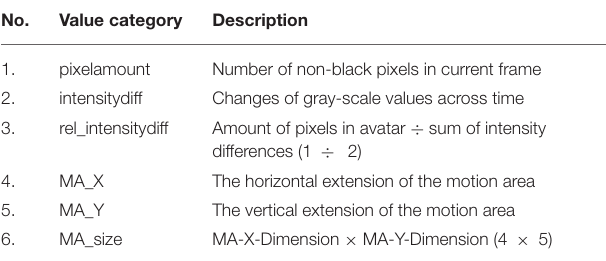
TABLE 3 | Overview of Value Categories Computed by Matlab